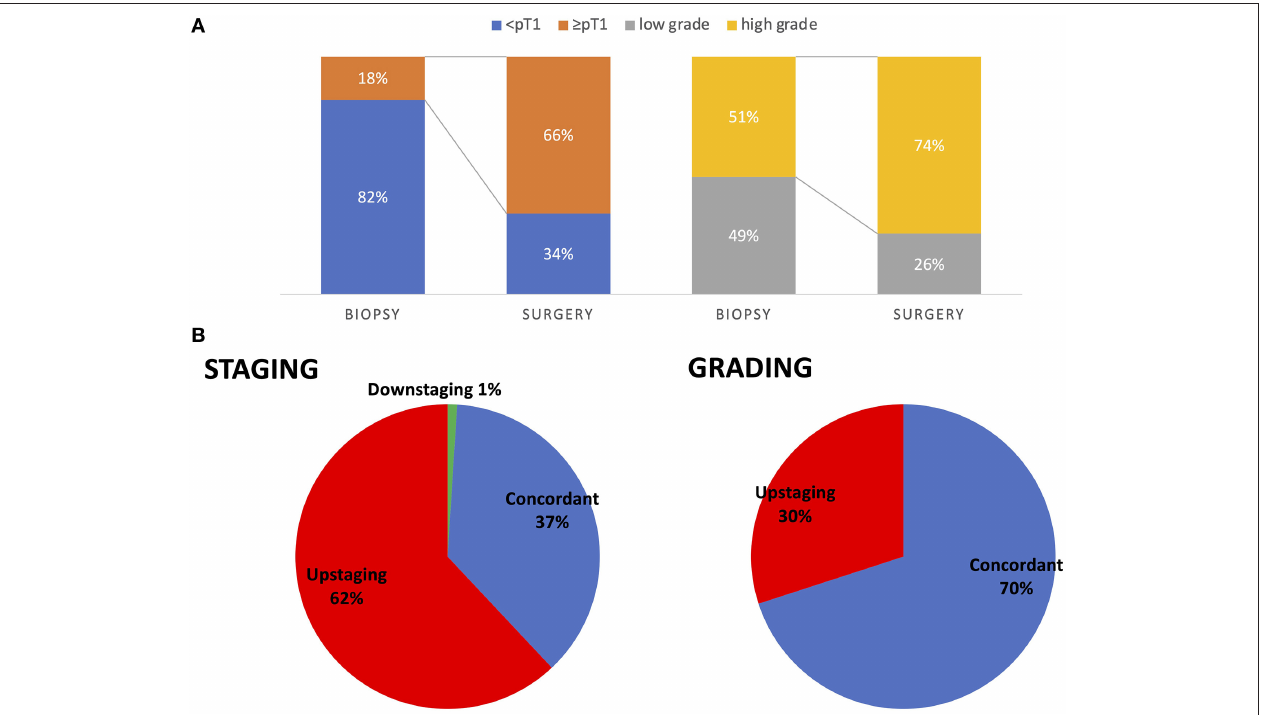
FIGURE 1 | Comparison of pre-operative biopsy to final pathology for pathologic staging and grading in all patients (A) . Rate of patients being upstaged from pre-operative biopsy to final pathology. Seventy percent (64 patients) had concordant pathologic grading in URS biopsy and final pathology and 30% (28 patients) were upstaged from low grade to high grade. Sixty-two percent (58 patients) had pathologic upstaging from URS to final pathology, 37% (35 patients) had concordant pathologic stage. One patient had downstaging of pTa tumor in URS and no malignant residual tumor in RNU (B)